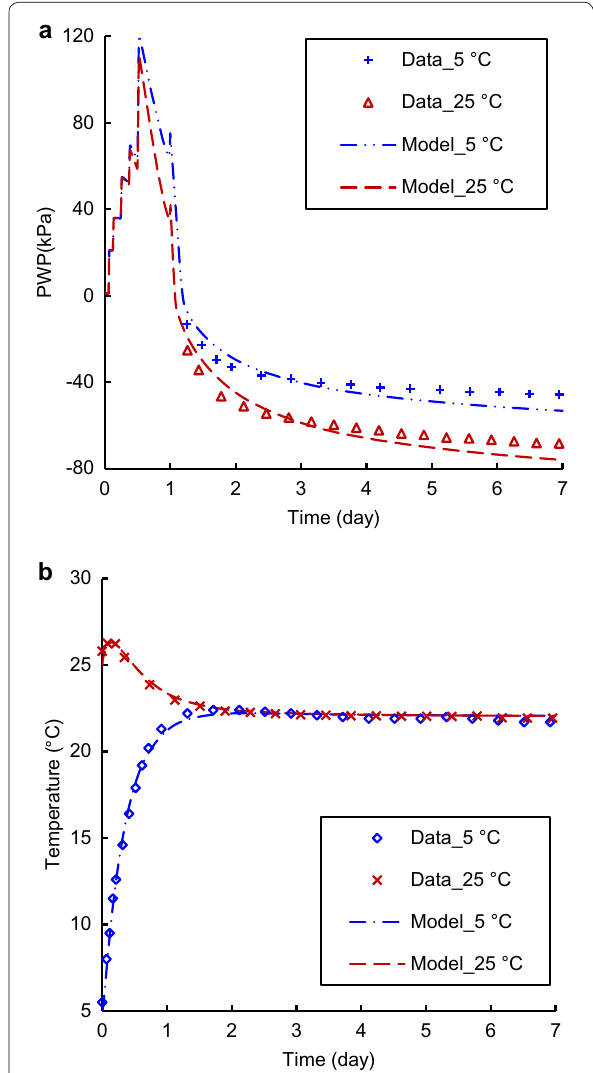
Fig. 4 Comparison of predicted results and measured data: a PWP; b